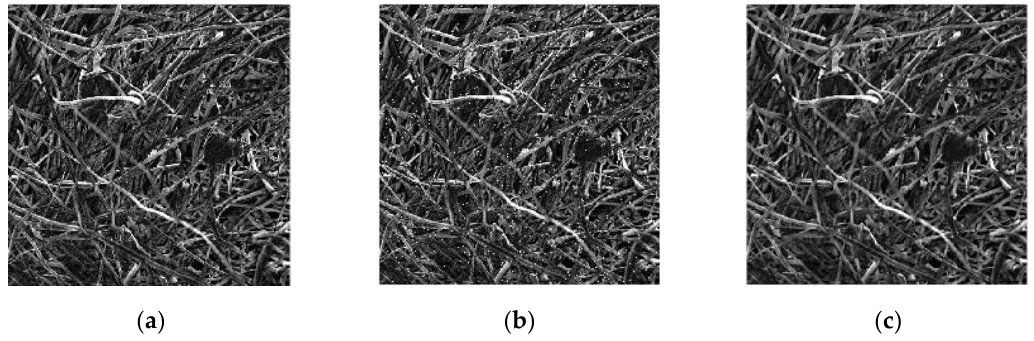
Figure 8. Median filtering process: ( a ) Original grayscale image ( b ) The noisy picture ( c ) Median filtered picture.